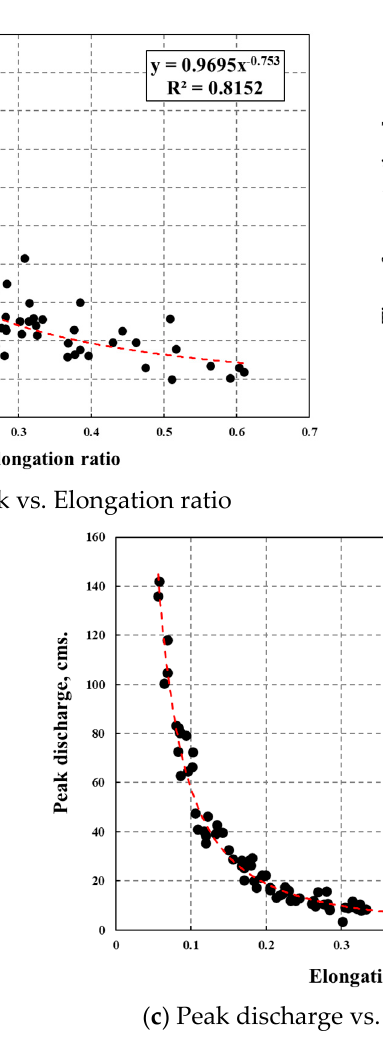
Figure 13. Relation between the morphometric parameters of watershed and components of unit hydrograph ( a ) Time to peak and elongation ratio; ( b ) Time of concentration and elongation ratio; ( c ) Peak discharge and elongation ratio.